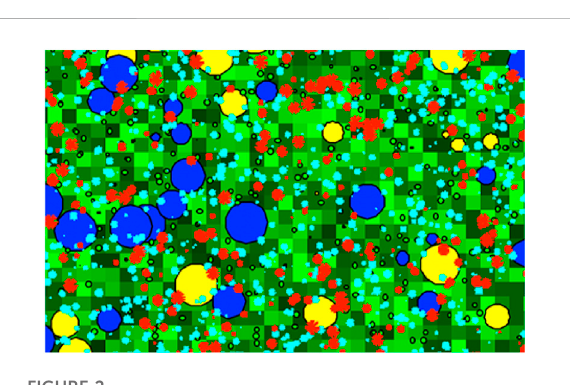
FIGURE 2 This 2D visualization shows the output generated by our biologically sound simulation model (SICCOM), which then gets converted into 3D models of corals in the virtual environment at runtime (Figure